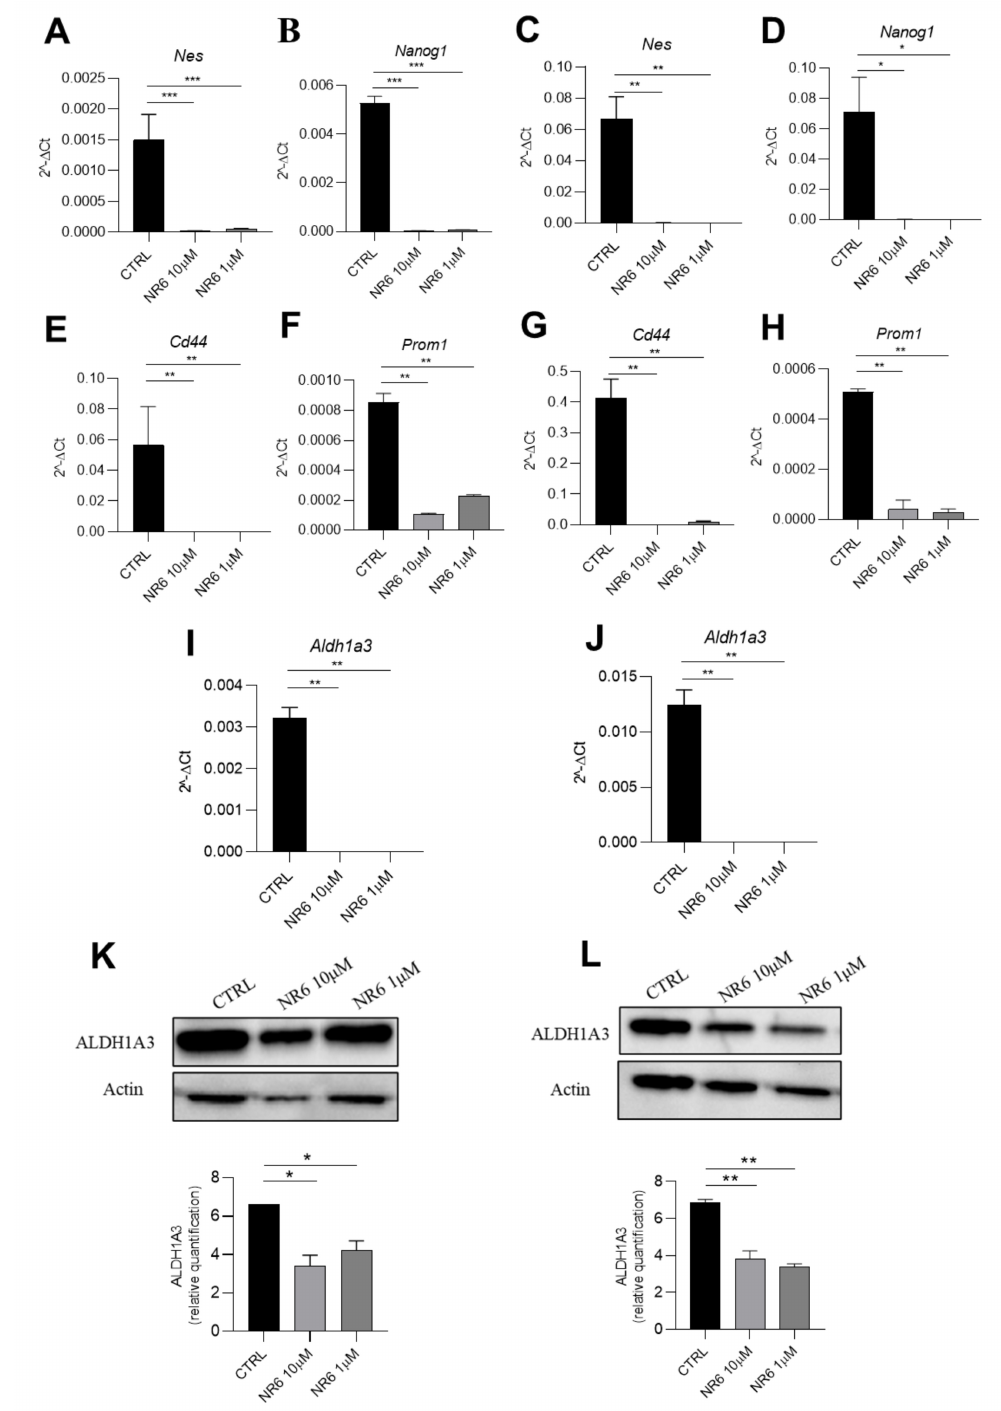
Figure 7. ALDH1A3 inhibitor is able to reduce stemness in vitro. Gene expression analysis quantified by qPCR of ( A ) Nes; ( B ) Nanog1 in HCT116; ( C ) Nes; ( D ) Nanog1 in U87MG cells. Gene expression analysis quantified by qPCR of ( E ) Cd44; ( F ) Prom1 in HCT116 and ( G ) Cd44; ( H ) Prom1 in U87MG. Gene expression analysis quantified by qPCR of Aldh1a3 ( I ) in HCT116 and ( J ) U87MG cells. Cells were treated with vehicle, NR6 10 and 1 µ M. ( K ) Representative western blot (top) and quantification (bottom) of shALDH1A3 in HCT116 cells treated with vehicle, NR6 10 and 1 µ M. ( L ) Representative western blot (top) and quantification (bottom) of shALDH1A3 in U87MG cells treated with vehicle, NR6 10 and 1 µ M. Values are means ± SEM (*** p < 0.001, ** p < 0.01, * p < 0.05, with non-parametric Kruskal-Wallis test followed by a Dunn’s multiple comparison